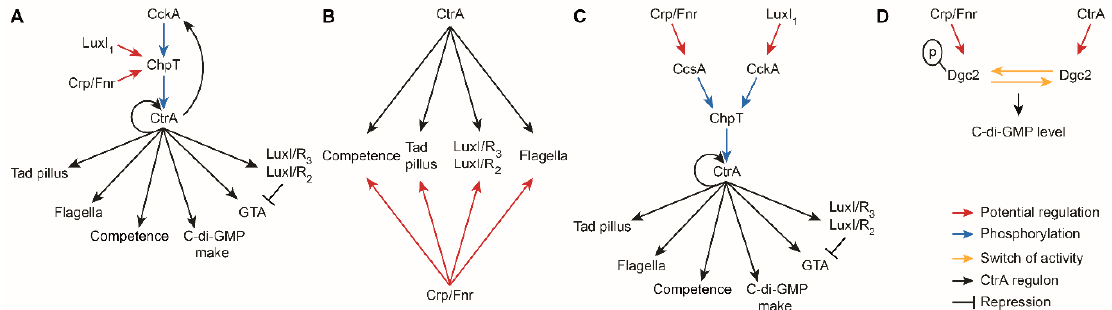
Figure 6. Possible mechanisms of integration of the Crp / Fnr and CtrA systems. ( A ) The LuxI 1 and Crp / Fnr signals could be integrated into the CtrA phosphorelay via chpT regulation, which does not happen via CckA or CtrA. ( B ) Shared binding site motifs for Crp / Fnr regulators and CtrA might allow direct integration of the NO / oxygen signal into the CtrA regulon. ( C ) An additional histidine kinase (CcsA) has been reported to phosphorylate ChpT in another bacterium, and this could integrate the Crp / Fnr signals and disconnect CckA from the integration. ( D ) Phosphorylation of the Dgc2 receiver domain likely regulates the enzyme’s diguanylate cyclase activity and thereby alters the intracellular levels of c-di-GMP, which are known to affect the CtrA regulon.